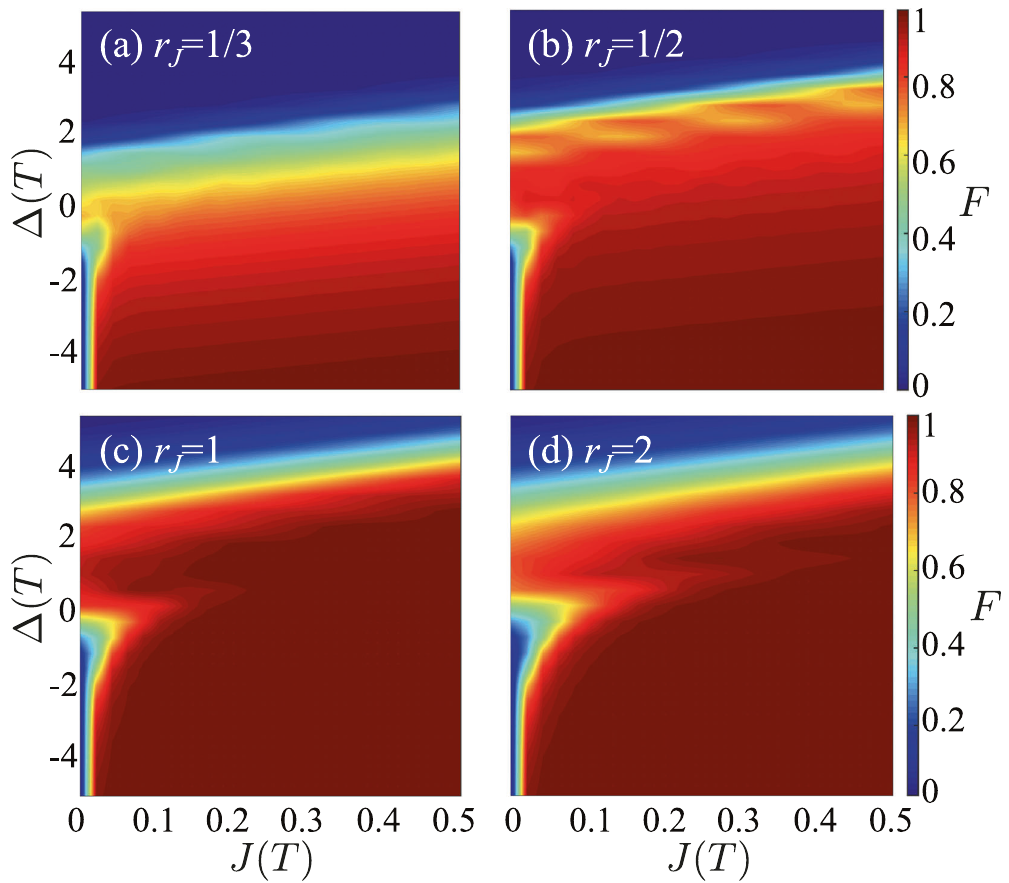
Fig. 6 Fidelity with SF initial state. a – d Fidelity of the prepared state F vs target hopping rate J ( T ) and target detuning Δ ( T ) for ramping index r J given in the panel. Here g (0) = 0, g ( T ) = 1, J (0) = 0.5, Δ (0) = 0, r g / r J = r Δ / r J = 1, and T = 15 π / g